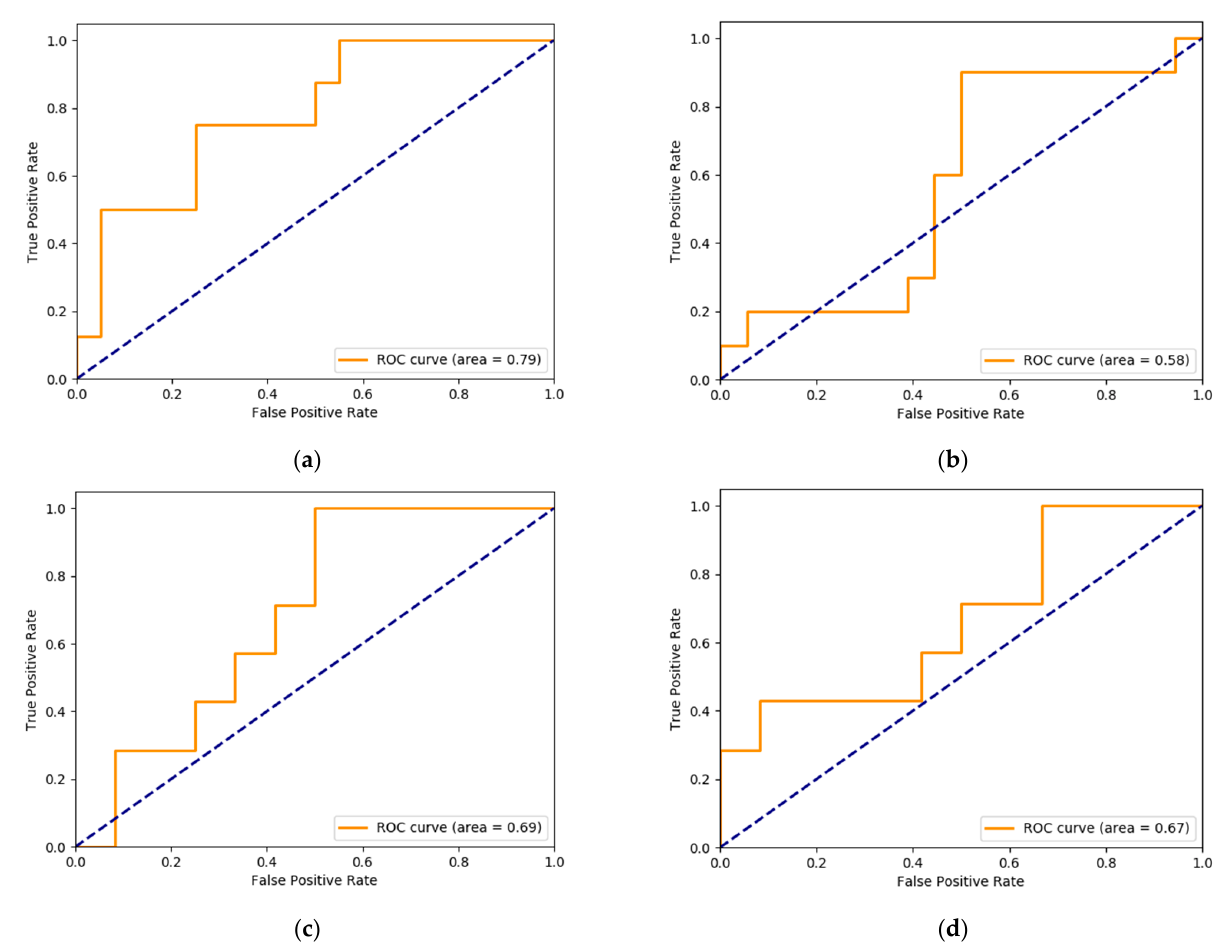
Figure 2. AUC curve predicting minor and major episodes using MLP: ( a ) AUC for minor episode, 7:3 training; ( b ) AUC for major episode, 7:3 training; ( c ) AUC for minor episode, 8:2 training; ( d ) AUC for major episode, 8:2 training; We only have the averaged result (for all the episodes) in Table 4, while this figure incorporates the result for each major and minor episode. Abbreviations: MLP—multi ‐ layer perceptron, AUC—area under curve. Table 4. Machine learning model performance through voice features. 7:3 8:2